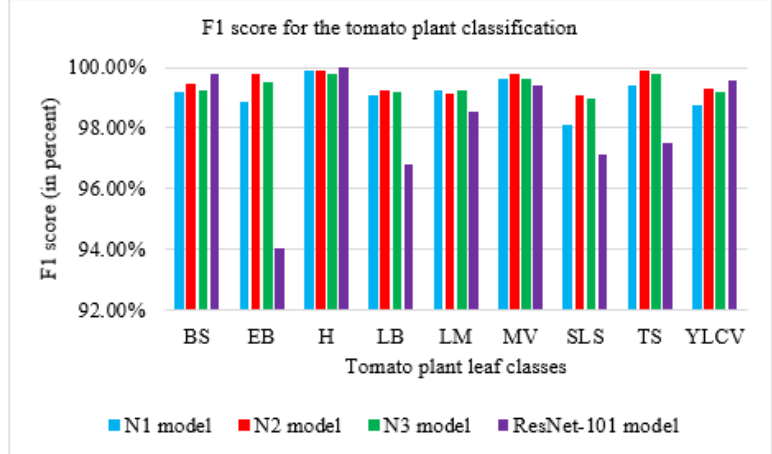
Figure 12. F1-score performance for TPL classes.